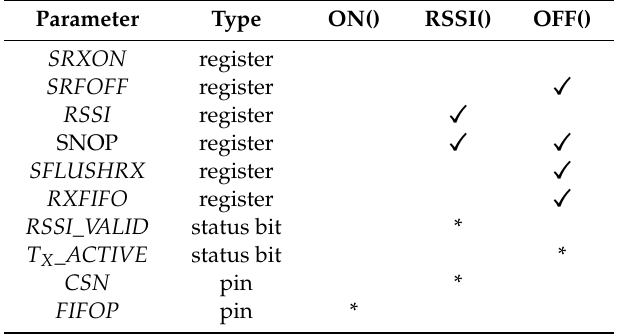
Table 1. Participants in one idle listening based on CC2420 driver source code in Contiki OS.